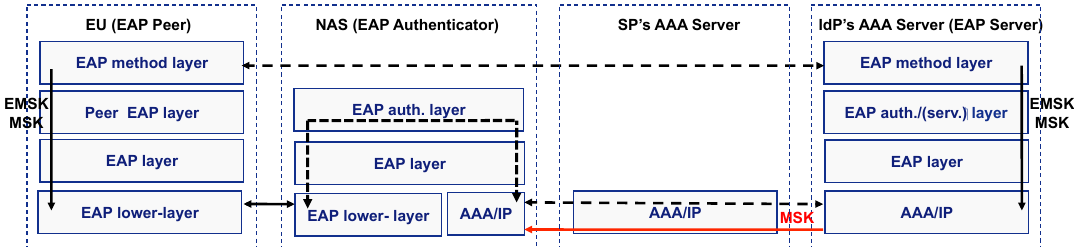
Figure 1. Extensible Authentication Protocol (EAP) pass-through